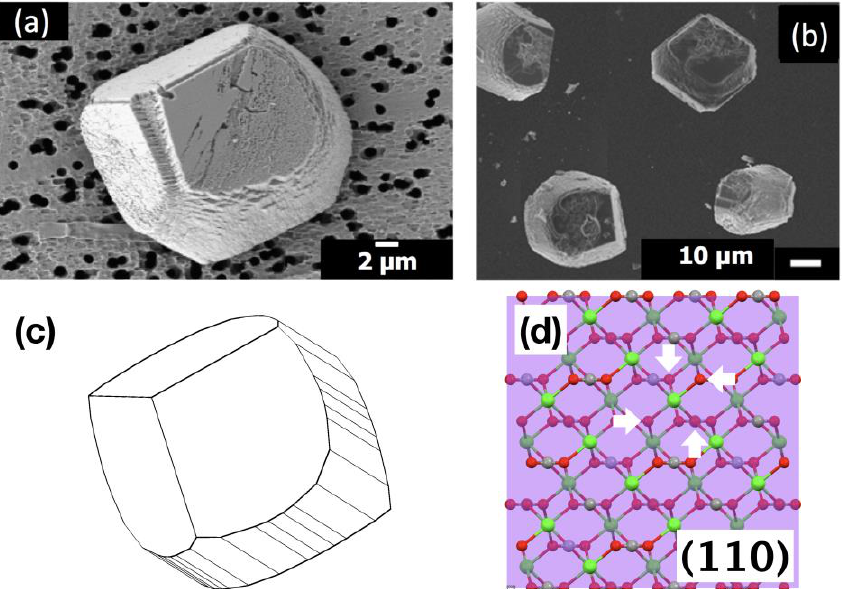
Figure 7. SEM images of the calcite crystals formed with: ( a ) 5 μM PAA at Sr/Ca = 1:100; ( b ) 1 μM PAA at Mg/Ca = 1:10 (reproduced from reference [8]; copyright 2016 The Polymer Society of Korea); ( c ) simulated morphology of calcite with some {hk0} faces in addition to {104}; ( d ) deficient number (4) of oxygen (white arrows) surrounding a calcium on (110) plane (reproduced from reference [7]).